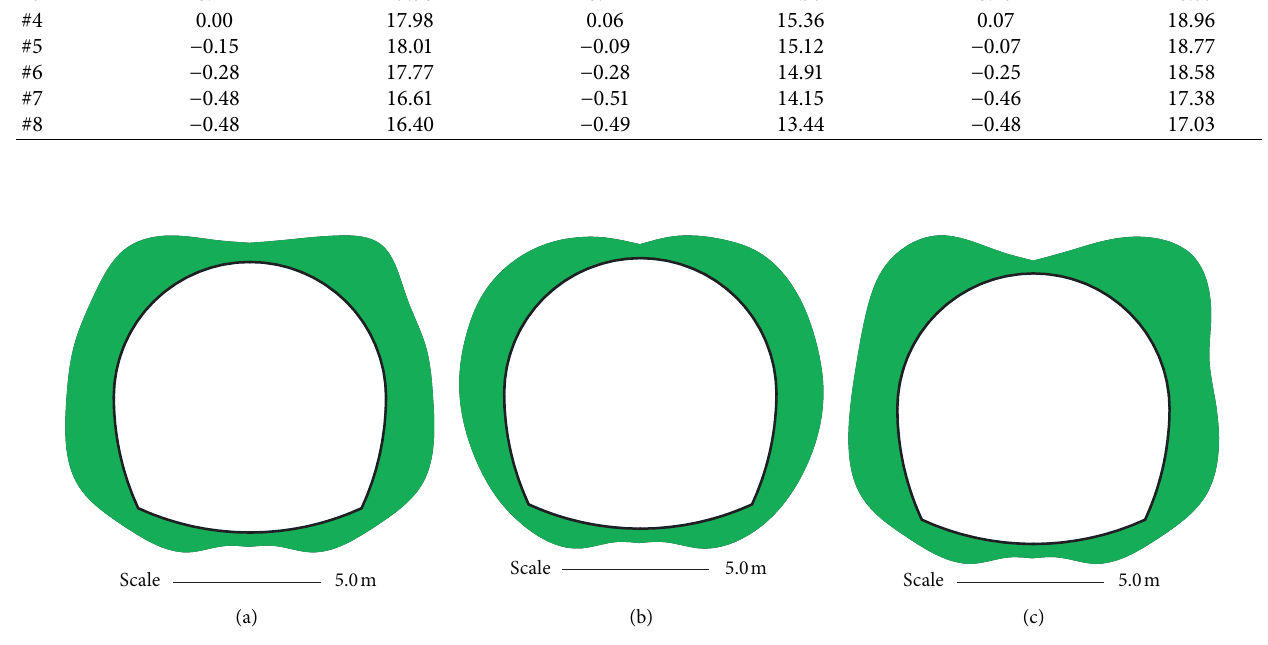
Figure 10: Plastic zone under three IESs: (a) IES1, (b) IES2, and (c) IES3. Table 5: Stress at the top and left sidewall points in the shotcrete